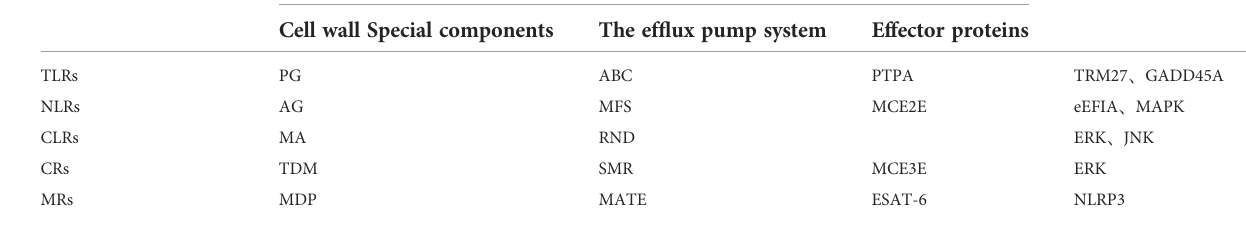
TABLE 1 Some immune escape molecules of MTB interacting with host cells.